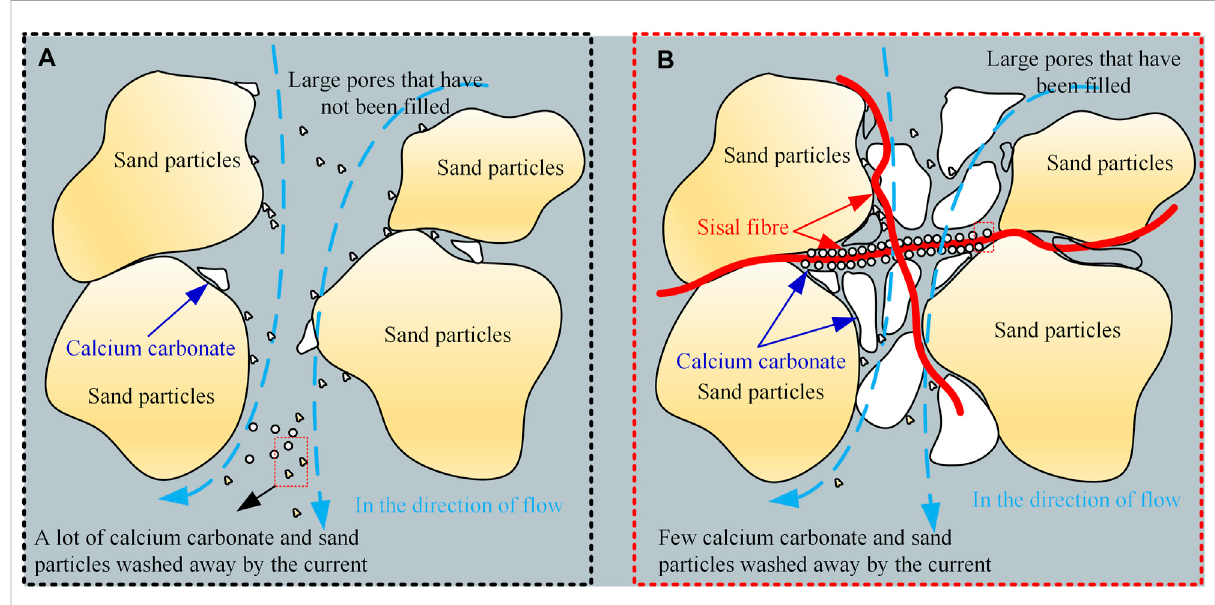
FIGURE 13 Themechanismofsisal fi bersinEICP-treatedsand:comparedbytheinternalstructureofsand (A) beforesisal fi berwasadded (B) aftersisal fi ber was